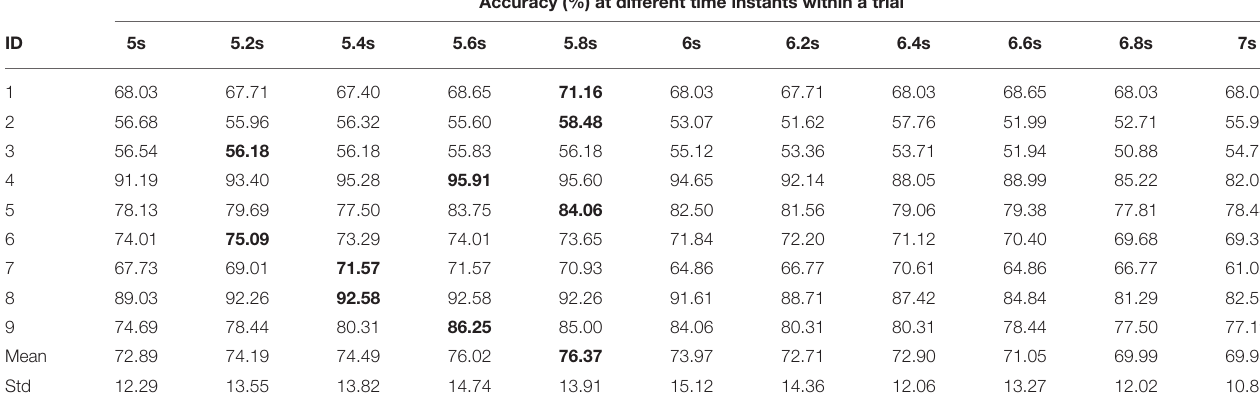
TABLE 8 | Performance of intra-subject learning for CA opt (highlighted in bold for each subject id).